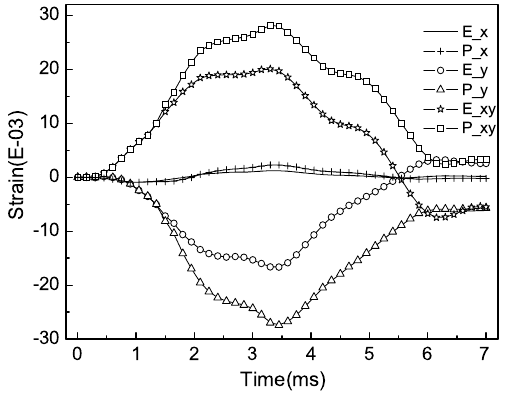
Fig. 18. Time history of strain at the center on inner surface for different material models of windshield.